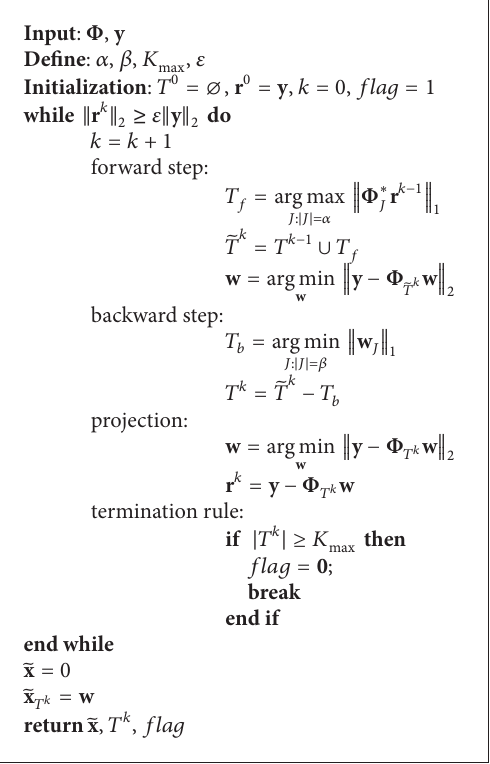
Algorithm 1: FBP algorithm